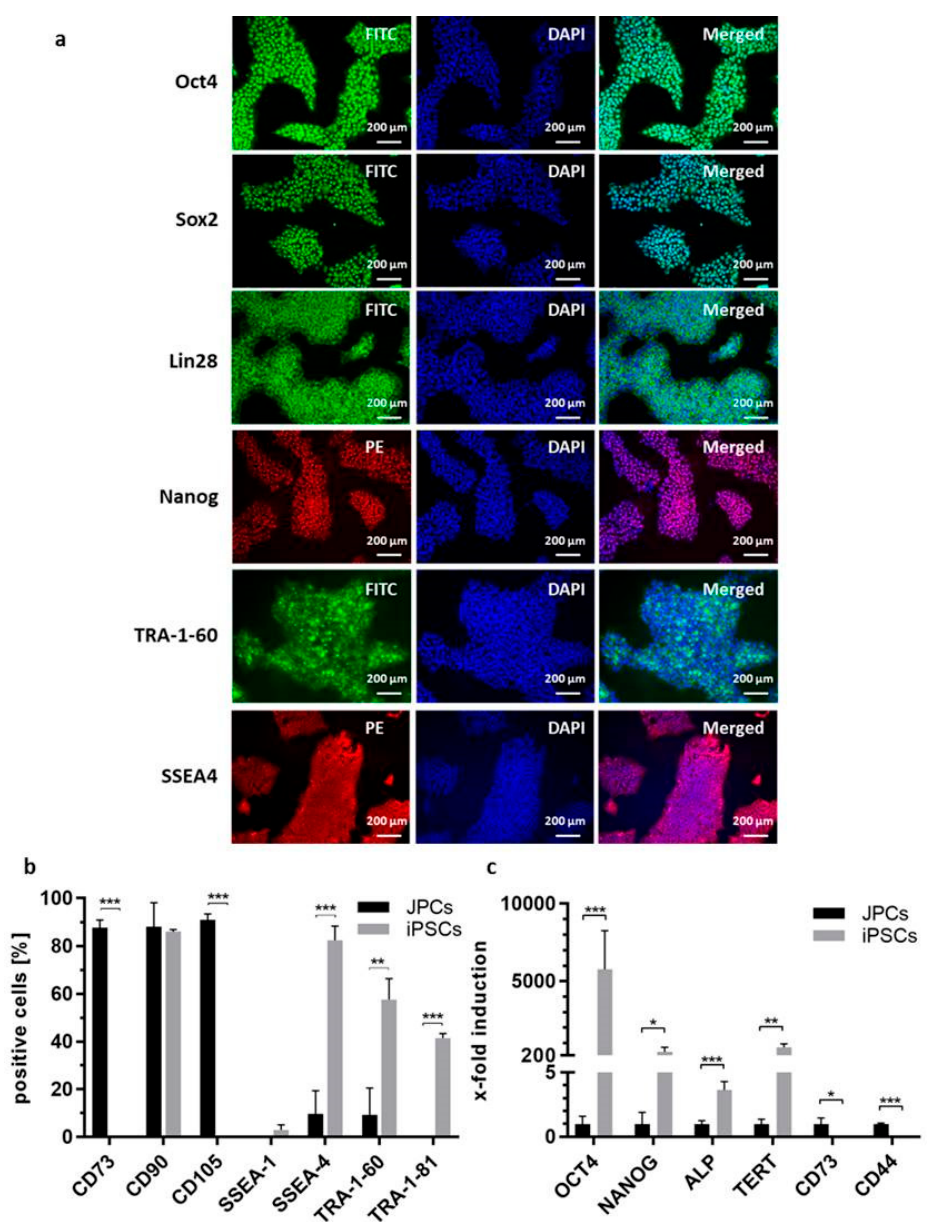
Figure 3. Pluripotency marker expression of JPC-derived iPSCs. ( a ) Oct4, Sox2, Lin28, Nanog, TRA-1-60 and SSEA4 immunostaining of iPSCs. ( b ) Surface marker expression of JPCs and JPC-derived iPSCs analyzed by flow cytometry and compared using Student’s t -test ( n = 3, ** p < 0.01, *** p < 0.001). ( c ) Gene expression analysis of JPCs and JPC-derived iPSCs by qRT-PCR. Gene expression levels were normalized to levels of GAPDH. Mean values + SD of iPSC and JPC gene expression were displayed relative to those of JPCs. Statistical significance was calculated using Student’s t -test. ( n = 3, * p < 0.05, ** p < 0.01, *** p < 0.001).